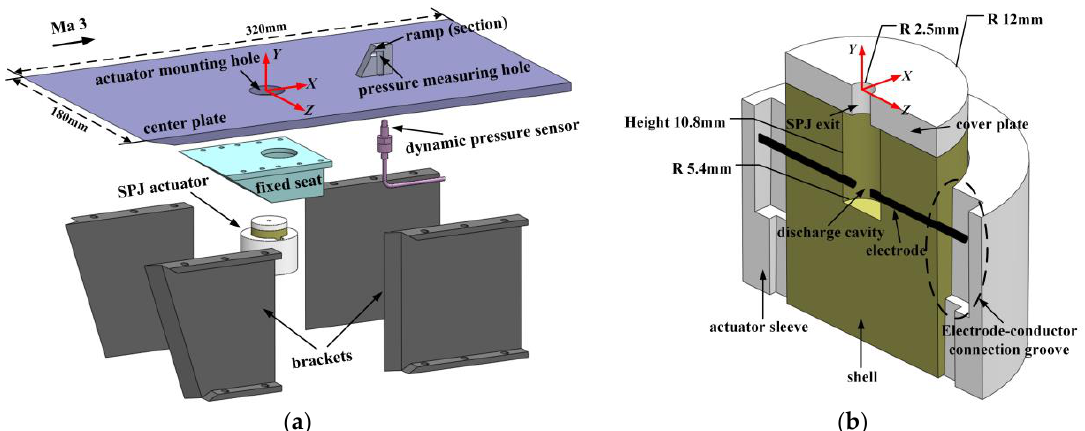
Figure 2. Schematic diagram of experimental model; ( a ) experimental model installation; ( b ) SparkJet (SPJ) actuator section view.